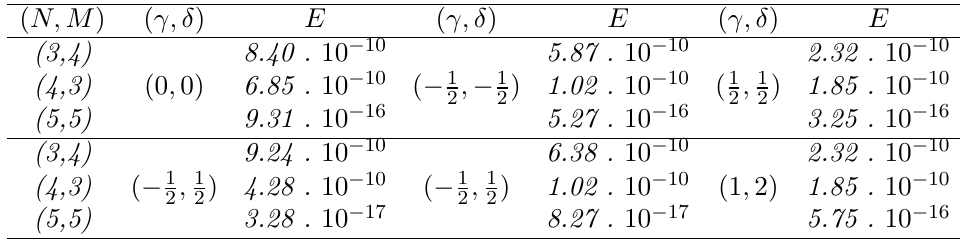
Table 2. Maximum absolute error of Example